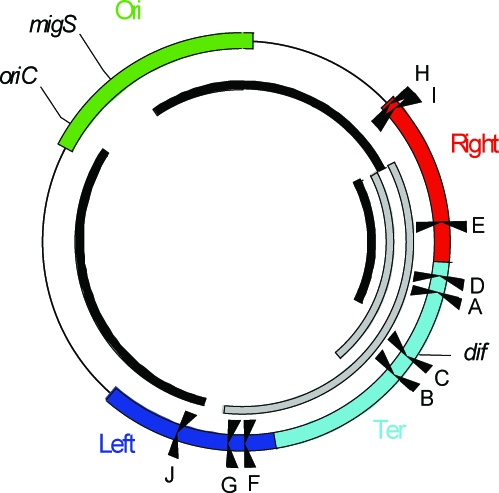
Detrimental Inversions in E. coli
Schematic representation of the E. coli chromosome showing MDs, Ter sites, oriC, migS, and dif. The black arcs indicate the position and extent of fragments for which inversion is detrimental for growth. Grey arcs indicate inversions between Right and Ter or Right and Left MDs that are tolerated. Well-tolerated intrareplichore inversions between NSright and adjacent MDs are not indicated. The analysis of detrimental and nondetrimental inversions supports a model in which the Ter MD is involved in a process that couples the end of replication in the Ter MD with a subsequent step. Inversion between Ori and Right MDs results in the perturbation of a process controlling chromosome segregation and cytokinesis.